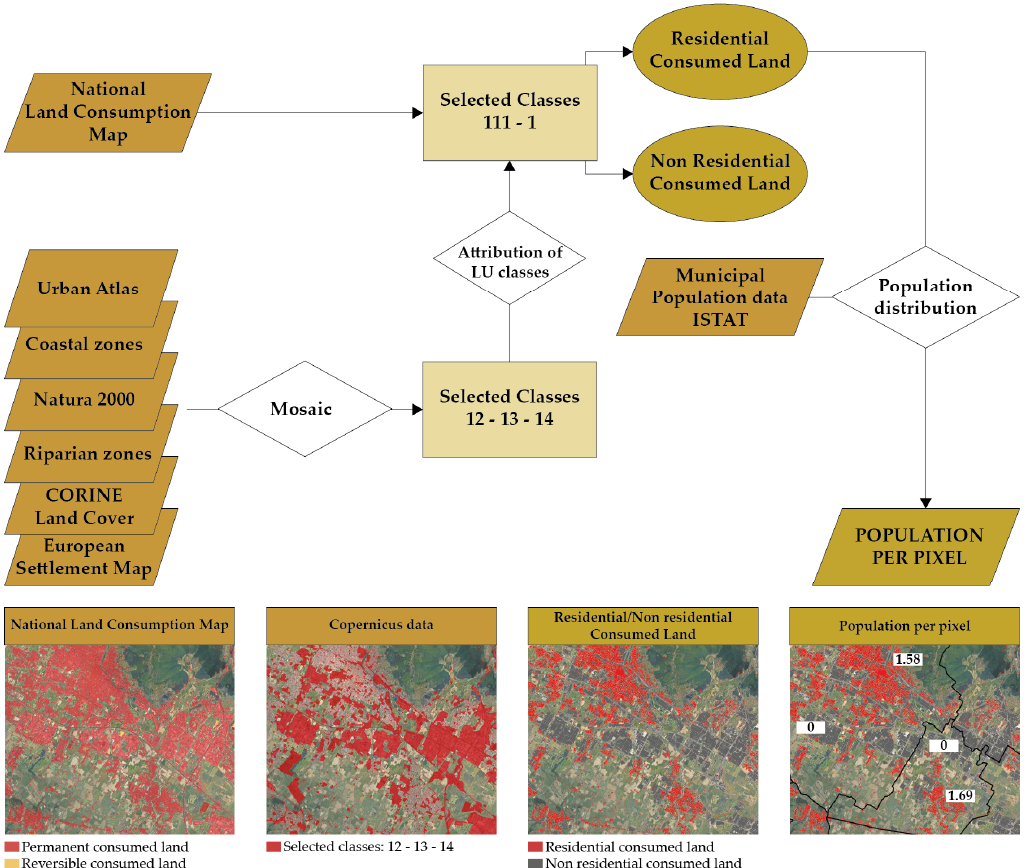
Figure 3. Workflow of the spatialization of population. The built-up areas were identified with the ISPRA LCM; among these, the residential buildings were selected thanks to the CLMS data and the ESM. The population was then distributed uniformly among all residential pixels.